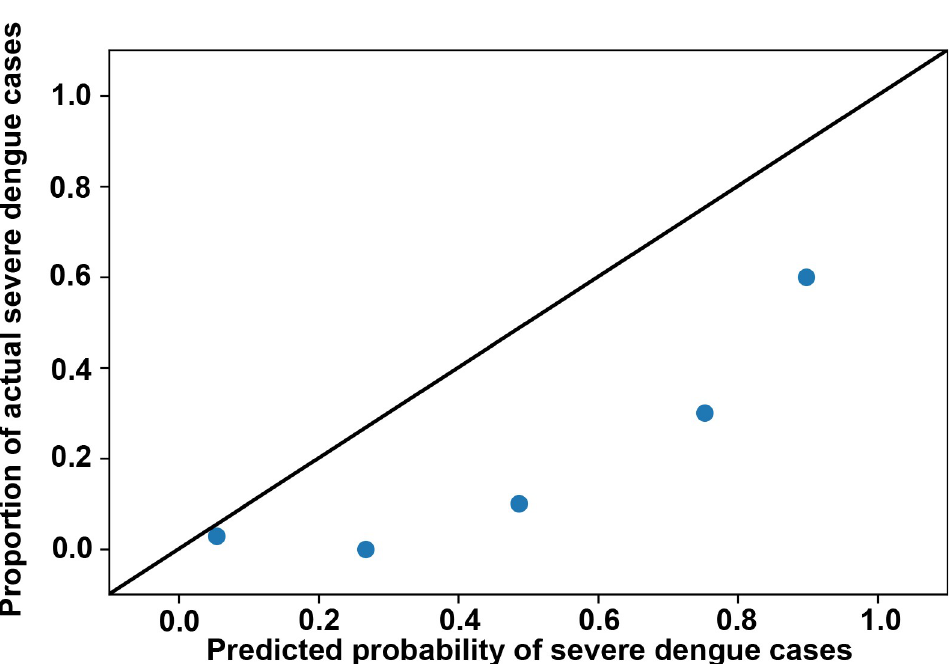
Fig 4. Calibration plot for the ANN model prediction. For the ANN model, the predicted probability of severe dengue cases is compared to the actual proportion of severe dengue cases among subjects in the 90–10 holdout test set. Perfect predictive ability is represented by the dashed diagonal